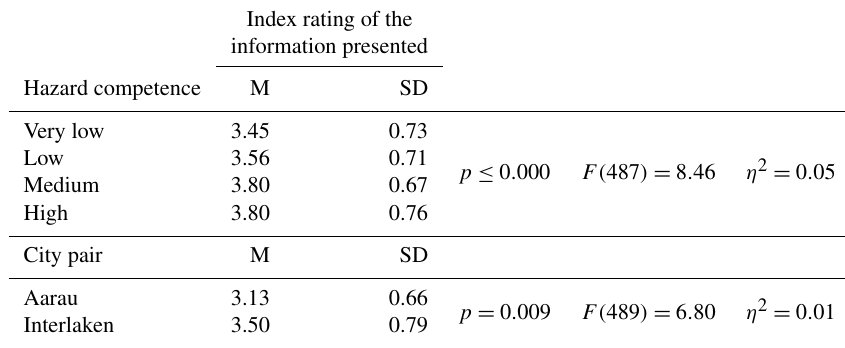
Table 7. Univariate analysis of variance with the index rating of the information presented as dependent variable and hazard competence or the city pair as independent variables ( N =